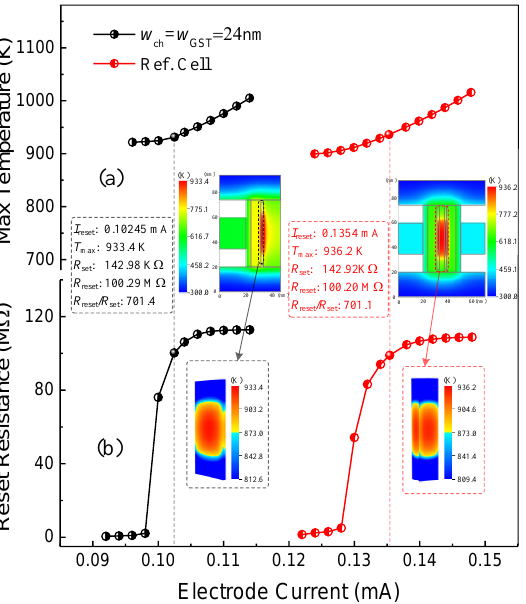
Figure 6. ( a ) Maximum temperature and ( b ) reset resistance of norm and stripe cells versus the reset current pulse amplitude. The inserts show the temperature distributions on symmetrical cross-sections and 3-D GST strips of cells at t = 1.8 ns.